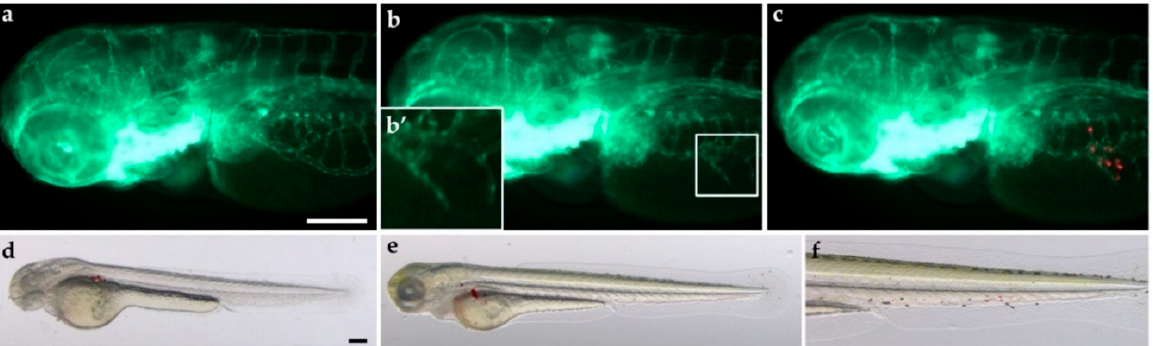
Figure 3. Tumorigenic potential of a lung carcinoid PDX in zebrafish embryos. Red-stained cells, obtained from a patient surgical resection, were used to perform PDX in 48 hpf Tg(fli1a:EGFP) y1 zebrafish embryos. Epifluorescence images at 24 hpi of cell resuspension solution injected embryos (control: a ) and patient-derived lung carcinoid (red) xenografted embryos ( b , c ). The red channel was omitted in panels ( b , b (cid:48) ) to facilitate the observation of tumor-induced angiogenesis (green); b (cid:48) is the digital magnification of the white-boxed region. Lung carcinoid PDX induced the formation of endothelial structures (green) sprouting from the SIV within 24 hpi. Overlay of representative fluorescent and bright field images of grafted embryos at 0 ( d ) and 48 hpi ( e , f ) showed the spread of tumor cells throughout the embryo body. The tail, particularly at 48 hpi, was imaged ( f ). Embryos are shown anterior to the left. Scale bar: 100 µ m.